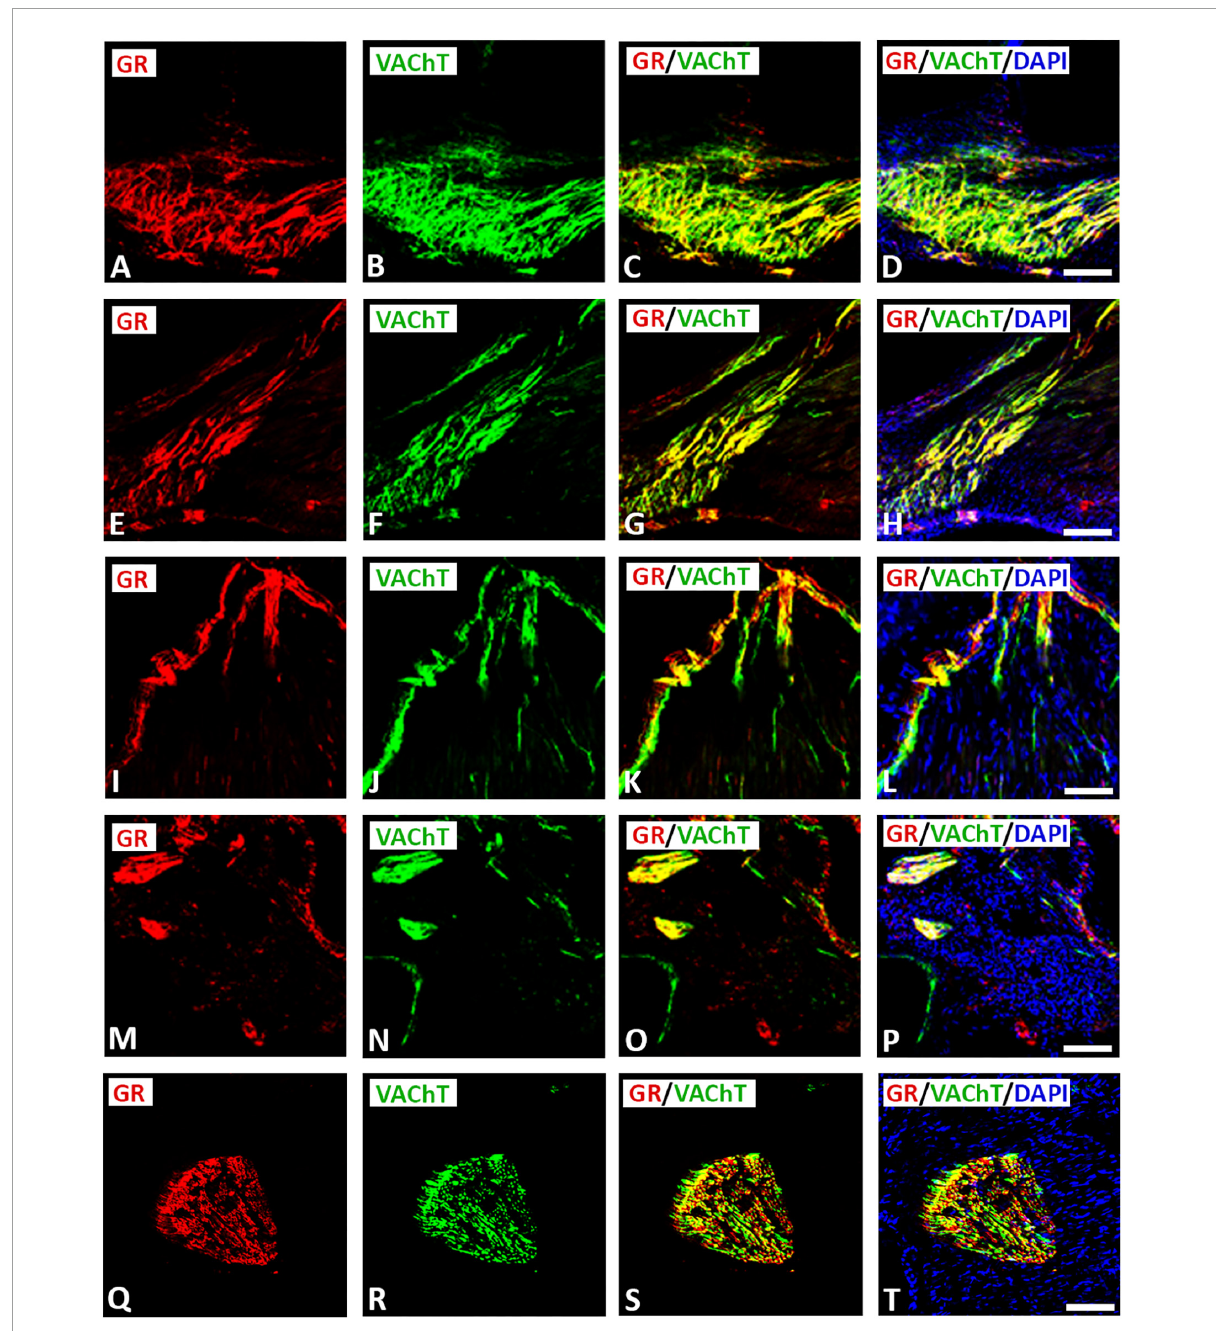
FIGURE3 Double immunofluorescence confocal microscopy of nerve terminals within rat atria co-expressing GR (A,E,I,M,Q) ( red fluorescence ) and/or parasympathetic neuronal marker VAChT (B,F,J,N,R) ( green fluorescence ). (A–H) Show predominant localization of GR with a VAChT-immunoreactive network of nerve fibers within rat atria. (I–P) Show bundles of VAChT-positive nerve fibers co-expressing GR immunoreactivity ( yellow fluorescence ) within rat atrium. (Q–T) Represent cross-sectioned nerves within heart atria contain high populations of VAChT-immunoreactive fibers expressing GR immunoreactivity ( yellow fluorescence ). (D,H,L,T,P) Show DAPI nuclear staining ( bright blue ). Bar: (A–P) = 40 µ m; (Q–T) = 60 µ m.